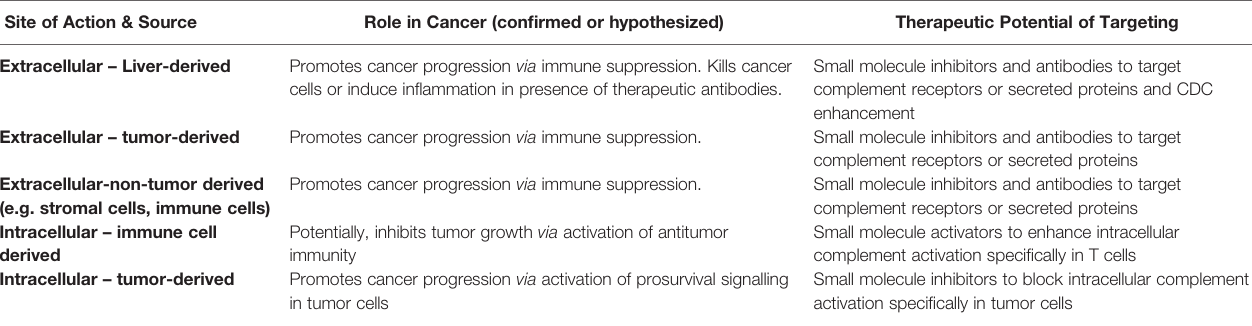
TABLE 1 | Sources, functions, and therapeutic potential of complement proteins in cancer. Site of Action &